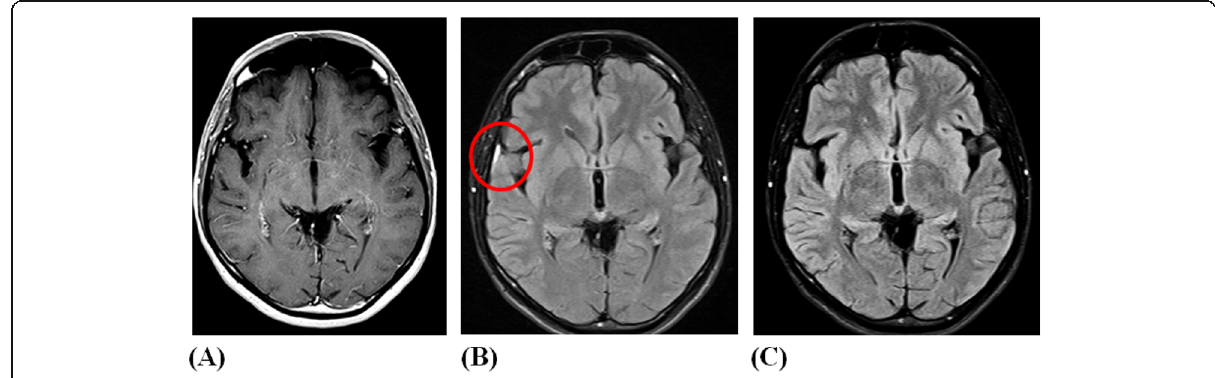
Fig. 5 Axial contrast-enhanced T1WI ( a ) shows no definite meningeal enhancement while contrast-enhanced FLAIR ( b ) shows small focal